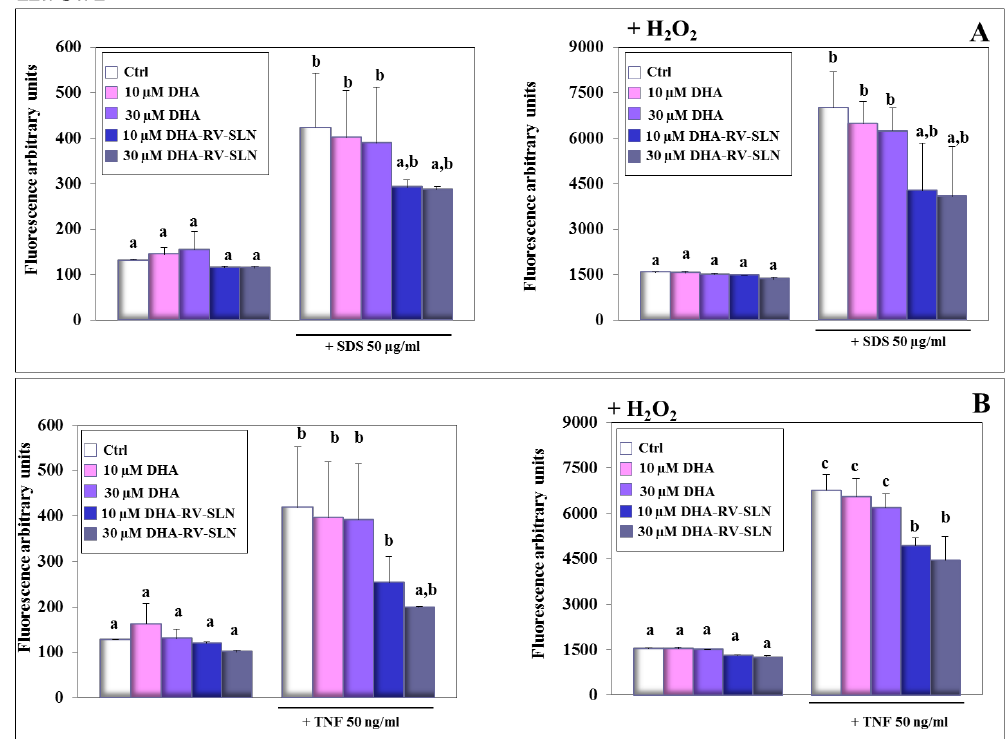
Figure 5. Effect of free DHA and DHA-RV-SLNs on ROS production in HaCaT keratinocytes treated with SDS or TNF-α. The cells were treated with free DHA or DHA-RV-SLNs (10 or 30 µM) in the absence or in the presence of 50 µg/mL SDS ( A ) or 50 ng/mL TNF-α ( B ) for 24 h, in basal conditions (left panels) or in the presence of 100 µM H 2 O 2 as a pro-oxidant stimulus (right panels). Data are the means ± SD of three different experiments. Values not sharing the same superscript letter are significantly different ( p < 0.05, one-way ANOVA followed by Tukey’s test).